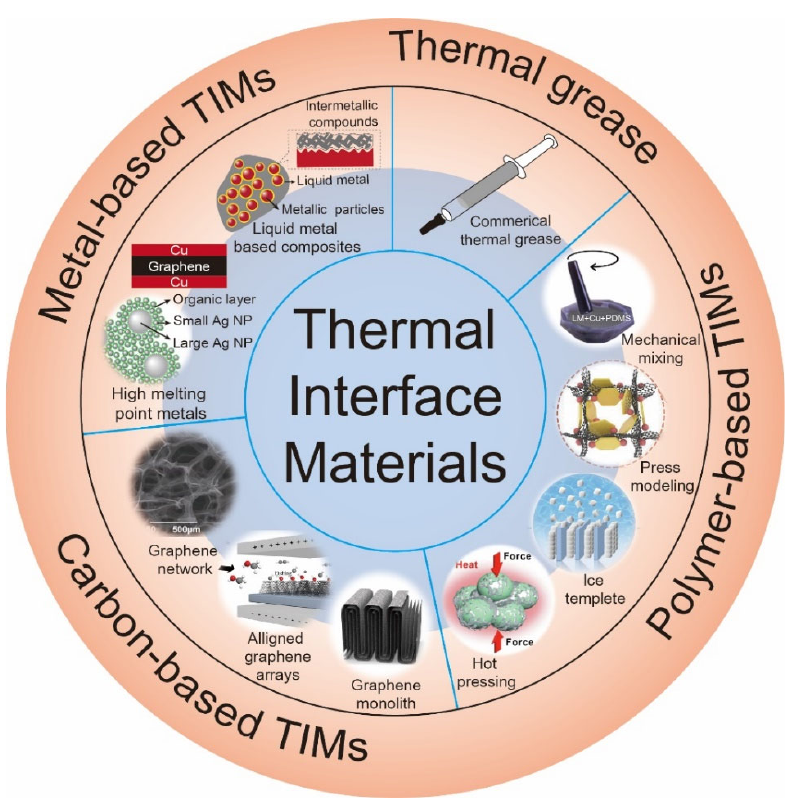
Figure 1. Schematic summary of advanced TIMs for the heat dissipation of high ‐ power